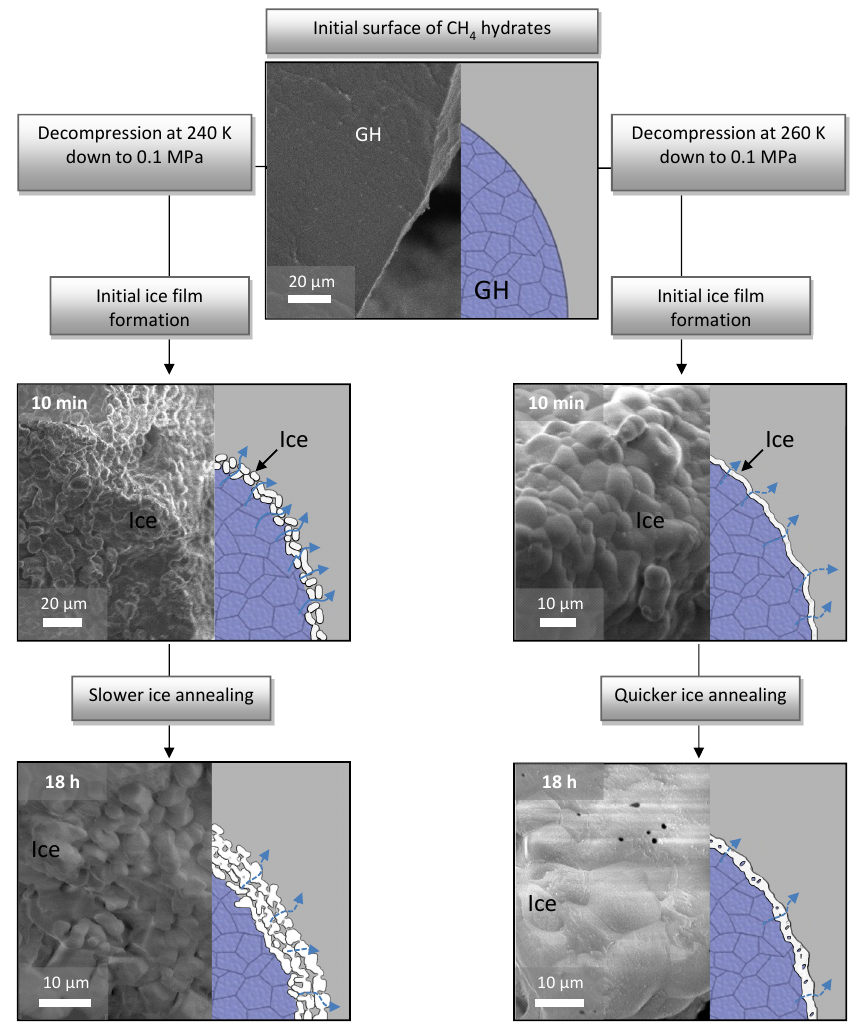
Figure 1. Formation of the self-preservation effect at 240 and 260 K through the stages of different initial ice microstructures and subsequent annealing. Reconstruction of the process shown on the right side of every picture is based on extensive cryo-FE-SEM imaging (left part of every